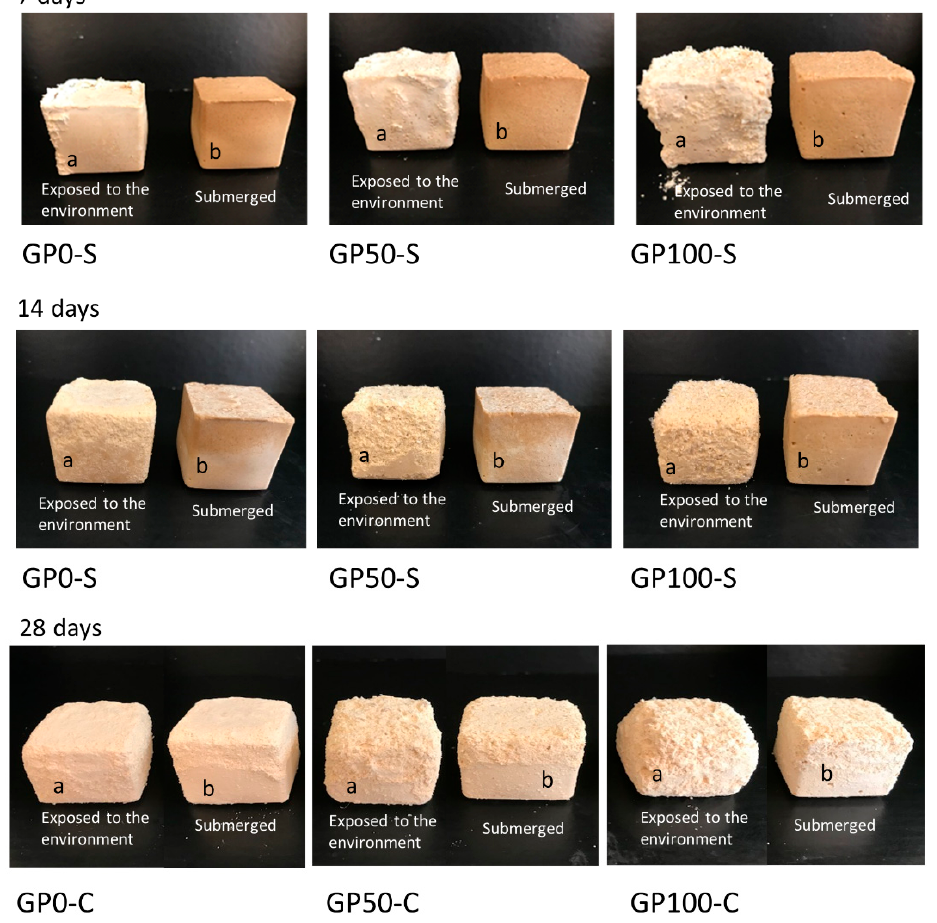
Figure 10. Photo of efflorescence formation with material degradation at 7, 14, and 28 days for samples exposed to the environment (a) and submerged (b).